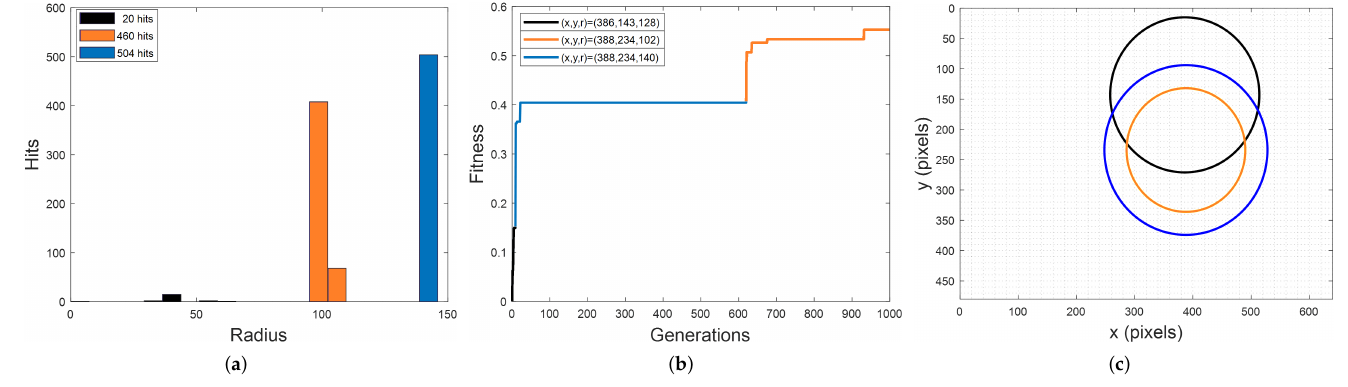
Figure 16. Hit distribution as a function of the radius ( a ), fitness evolution trend of the elite individual for 1000 generations ( b ), and circles detected corresponding to the fitness evolution trend ( c